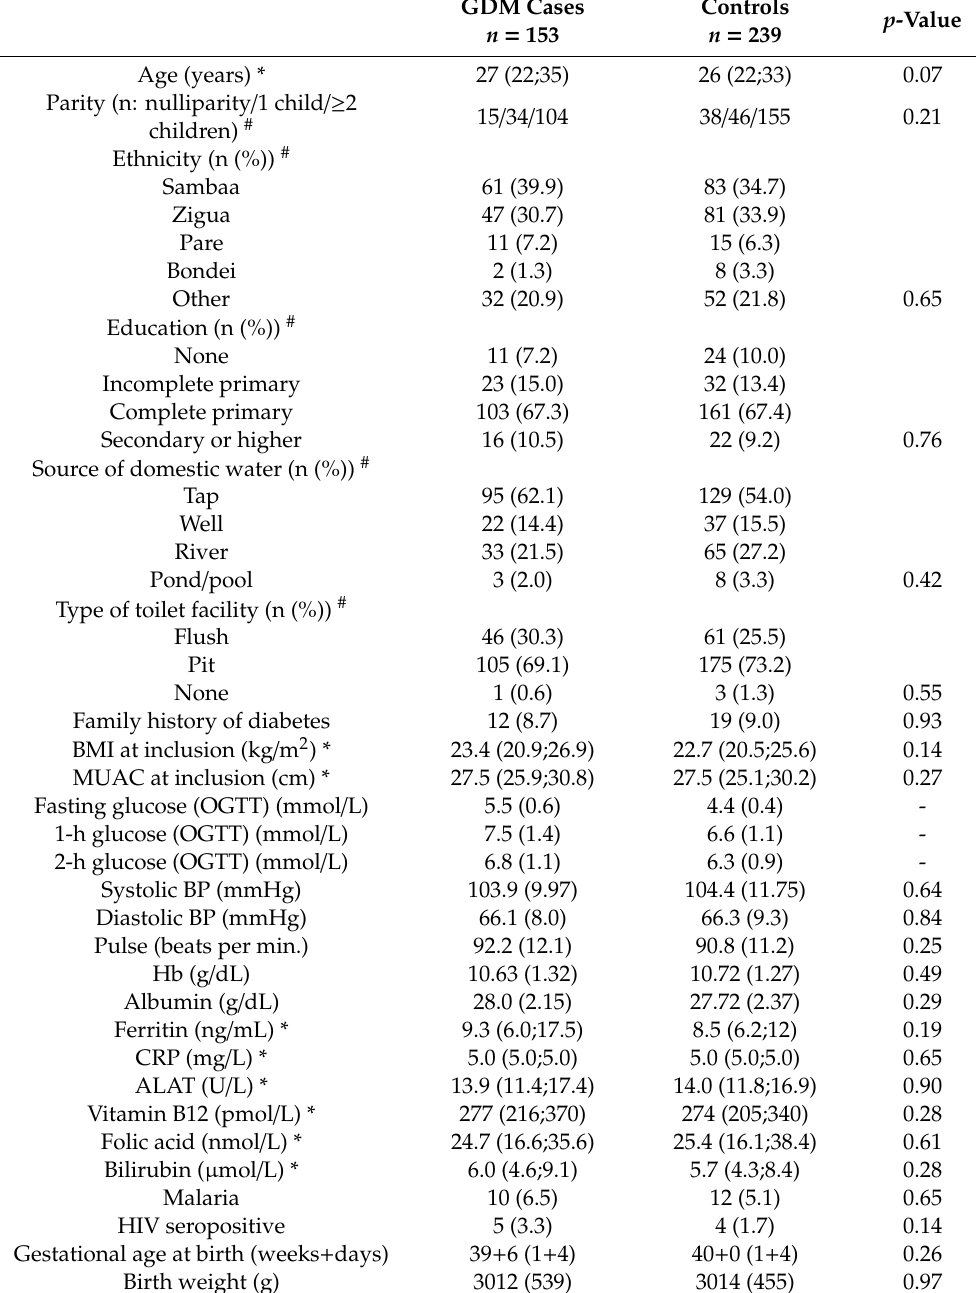
Table 1. Characteristics of the women who underwent an OGTT. GDM